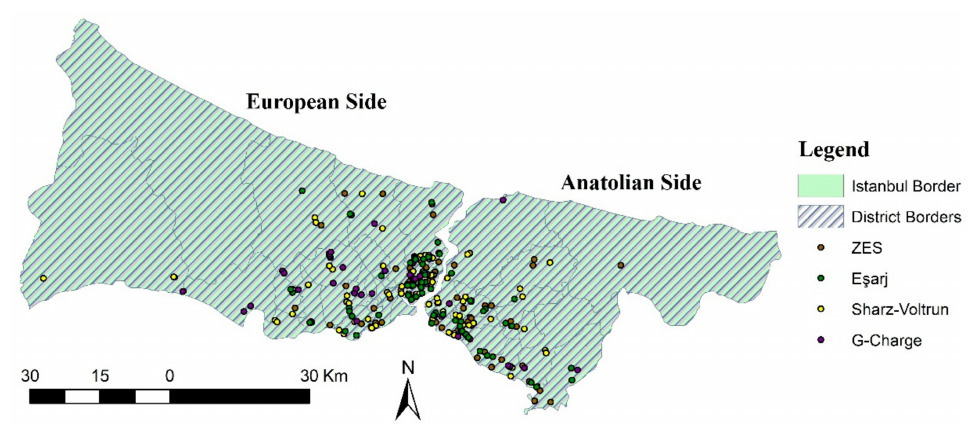
Figure 3. Study area.